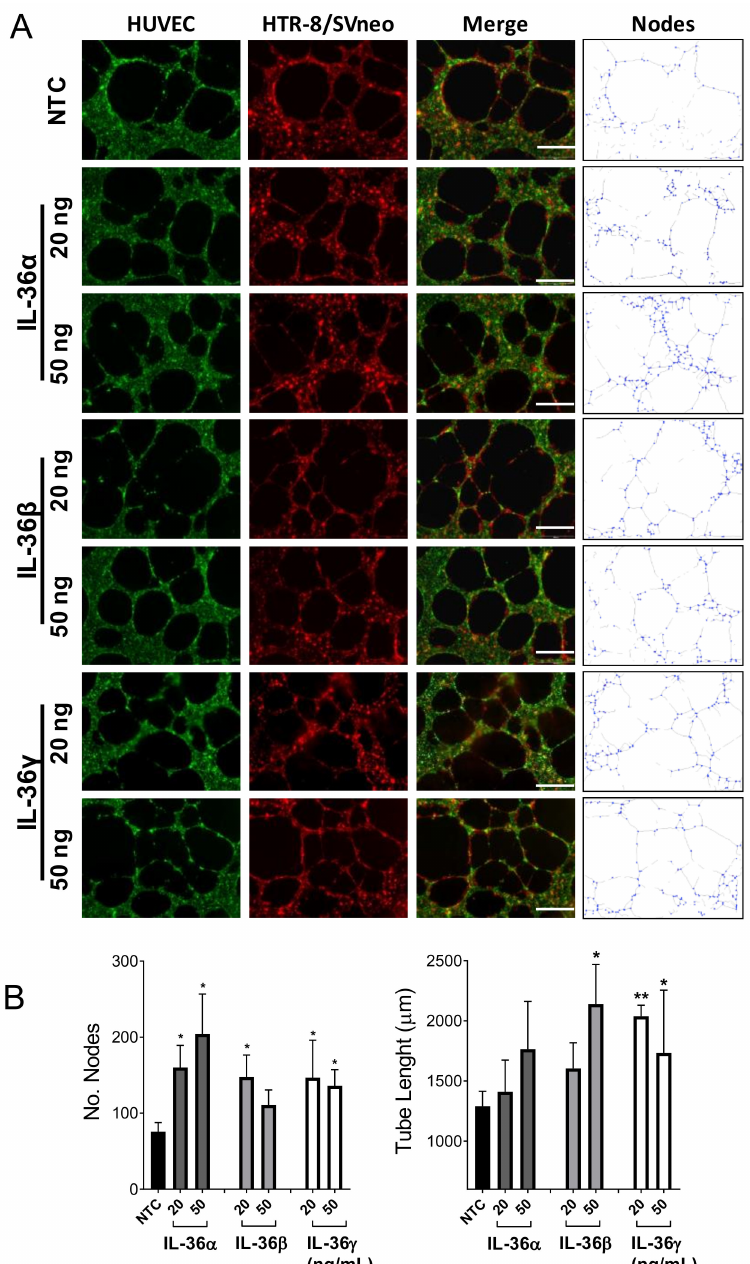
Figure 4. Effects of IL-36 ( α , β , and γ ) on the interaction between HTR-8/SVneo and endothelial cells. ( A ) Representative images of HUVECs (stained green) and HTR-8/SVneo cells (stained red) after 20 h of co-culture (merge) on a Matrigel ® -coated µ -plate. Nodes correspond to the analysis of merge images as shown in the right column. ( B ) Bars show the relative number of nodes and the tube length ( µ m) per condition in comparison with non-treated cells (NTC). Results from five independent experiments are shown as mean ± SEM. One-way ANOVA with Dunnett ´ s multiple comparison test. * p < 0.05, ** p < 0.01 for significant differences between respective IL-36 ( α , β , and γ ) treatments and NTC controls. Scale bar: 50 µ